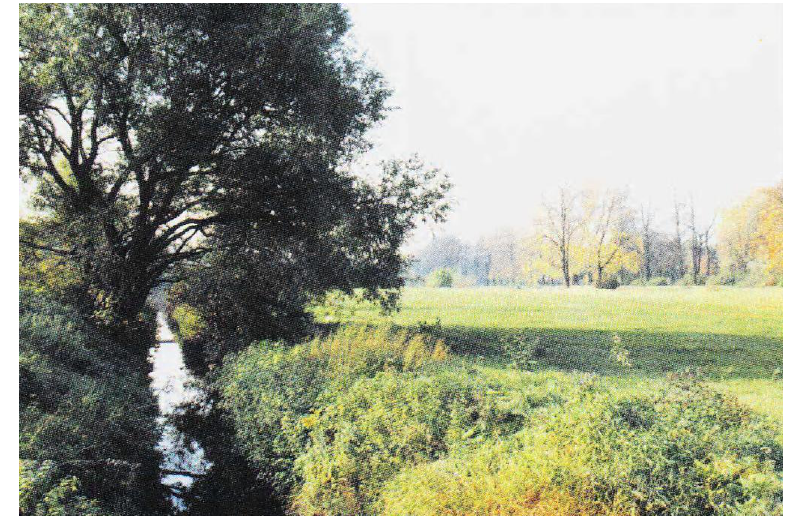
Fig. 9. Initial section of the River Jasień ( T. Jarząbek ) Fig. 10. River Jasień in the concrete channel – central river section ( B. Sierecka-Nowakowska )